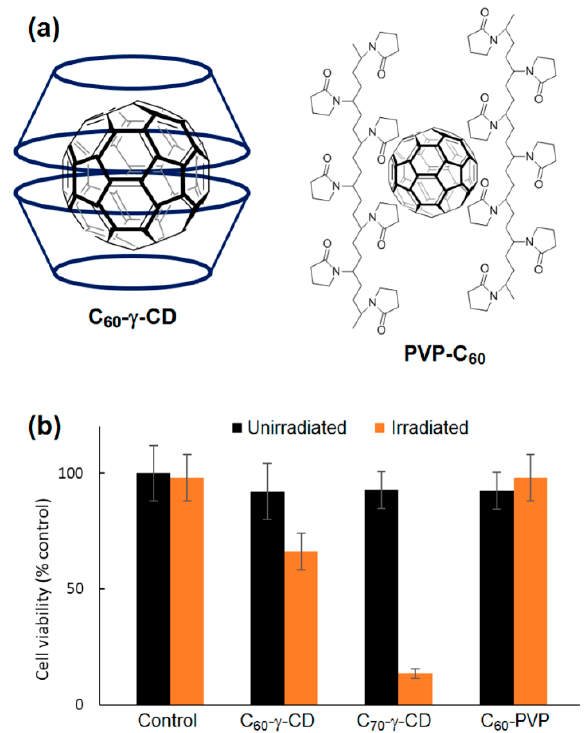
Figure 68. ( a ) Chemical structure of unmodified C 60 and C 70 dispersed in water using γ -CD (C 60 - γ - CD) and poly(vinylpyrrolidone) (C 60 -PVP). ( b ) 5RP7 cell viability (WST-1 assay). Cells treated with C 60 - γ -CD, C 70 - γ -CD, and C 60 -PVP aqueous solutions under irradiation ( λ = 633 nm, 3 mW/cm 2 for 1 h) compared to negative control (cell untreated). Adapted from Iizumi; Okazaki; Zhang; Yudasaka; Iijima [217].